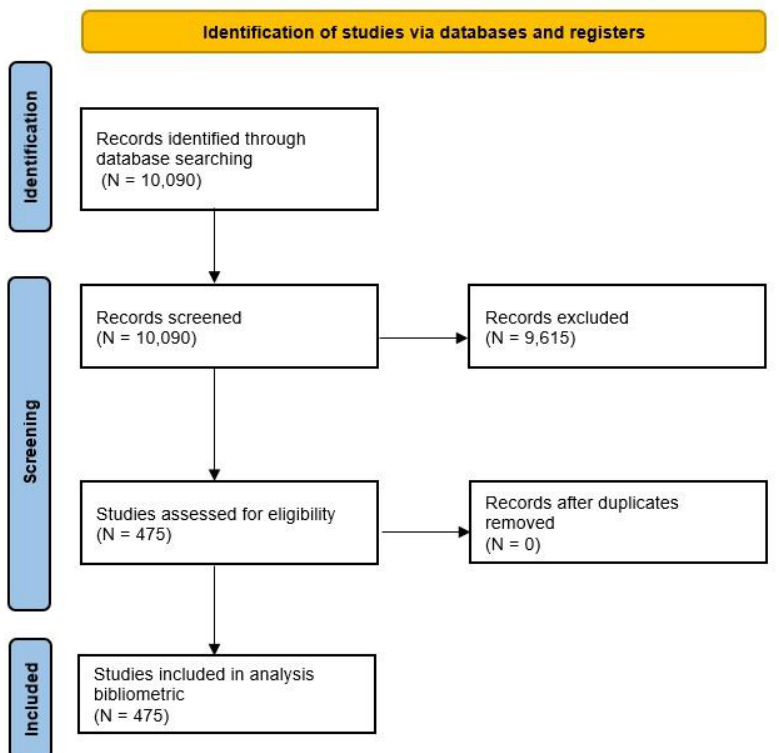
Figure 1. Review methodology based on PRISMA flow.